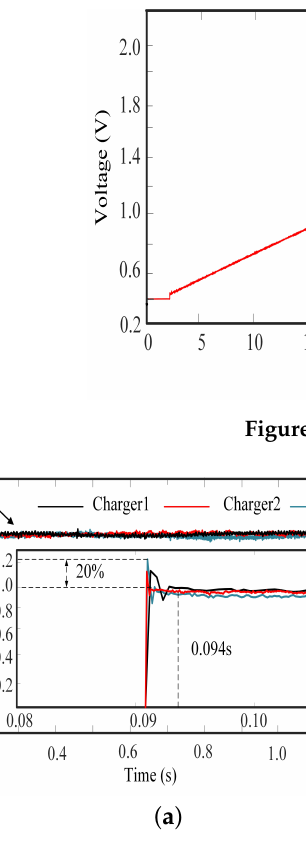
Figure 7. Experiment results of ( a ) the classical charging method and ( b ) the proposed charging